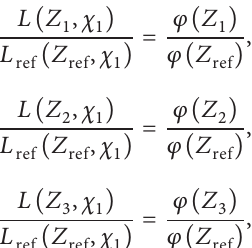
Note that (7) is the equation for the reference subzone , 𝜒 ) (𝑍 1 ref